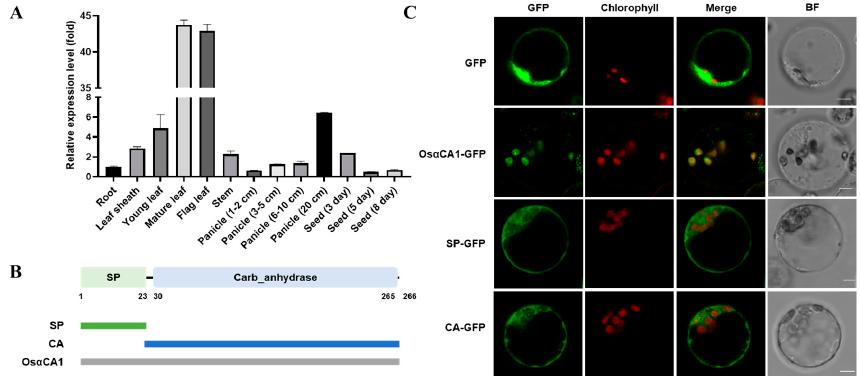
Figure 1. The tissue expression of Os α CA1 and the subcellular localization of its encoding protein. ( A ) The tissue expression of Os α CA1 in rice. The total RNA of various tissues, including root, leaf sheath, young leaf, mature leaf, flag leaf, stem, panicle, and seed, was extracted to analyze the expression of Os α CA1 via qRT-PCR, with Ubiquitin incorporated as the control. Values are shown as means ± SEM, where n = 3. ( B ) The signal peptide and the conserved domain of Os α CA1 and diagram of vector construction. The green rectangle represents the signal peptide termed SP, and the blue rectangle represents the CA domain termed CA. ( C ) The subcellular localization of GFP-fused proteins. The expression vectors of SP-GFP and CA-GFP were constructed; then, the protoplasts of the rice leaf sheath were transfected. GFP—the view via GFP fluorescence; BF—the view